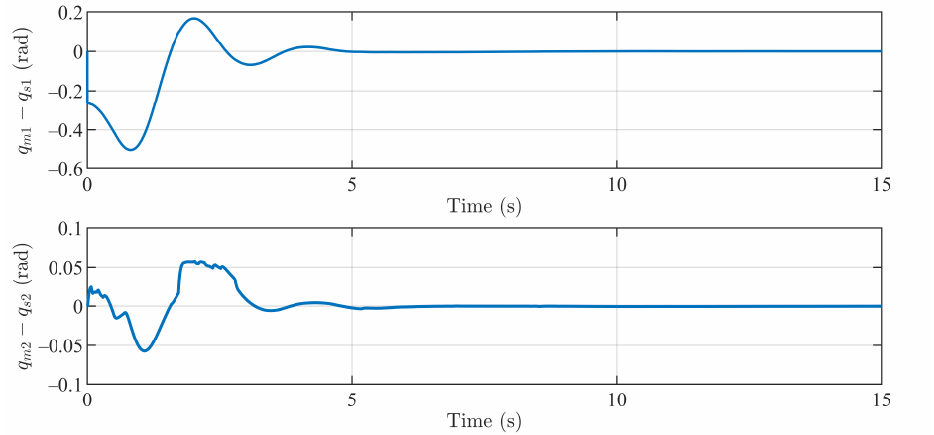
Figure 5. Joint positions of the master and slave end-effectors in the x-direction and y-direction.